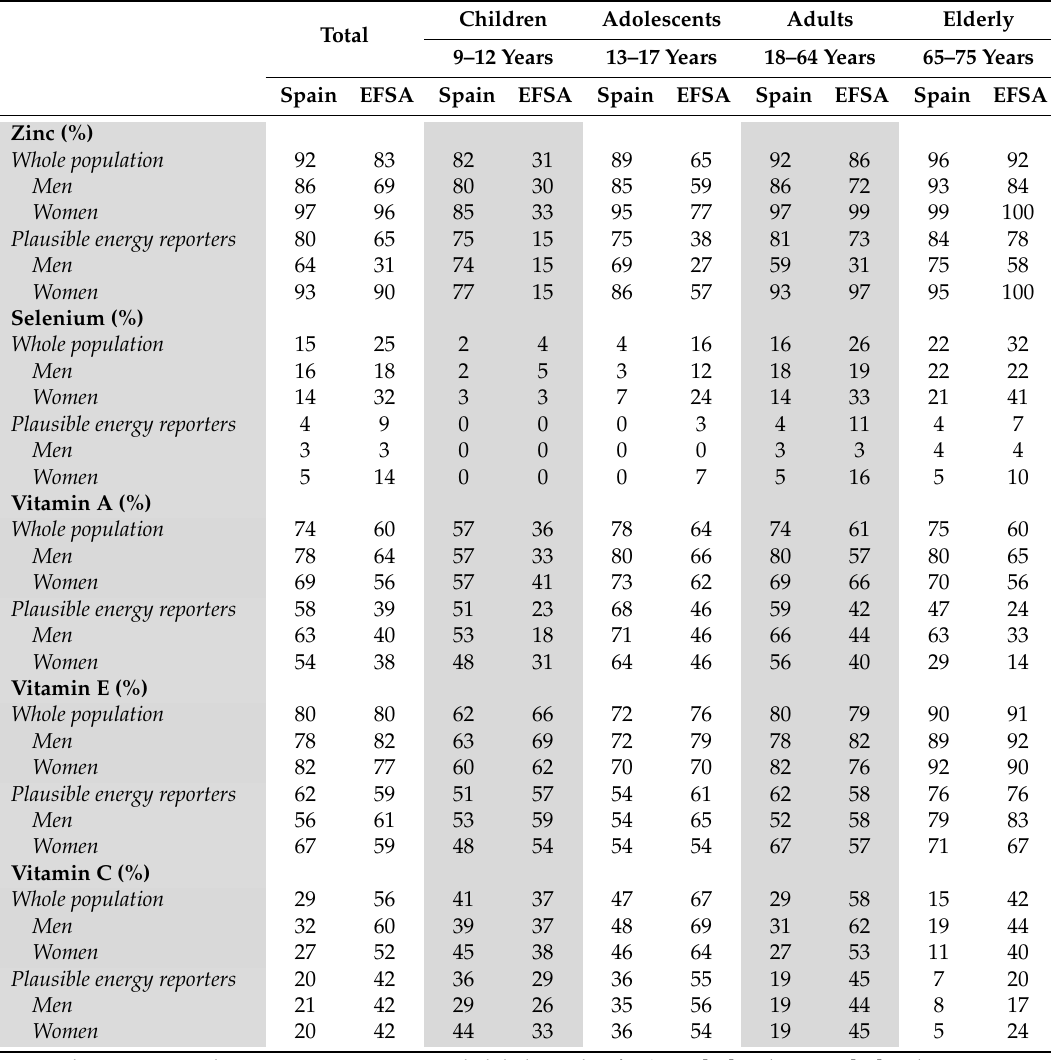
Table 4. Percentage of the population with inadequate intake of zinc, selenium and vitamins A, for the whole population and for the plausible energy reporters by